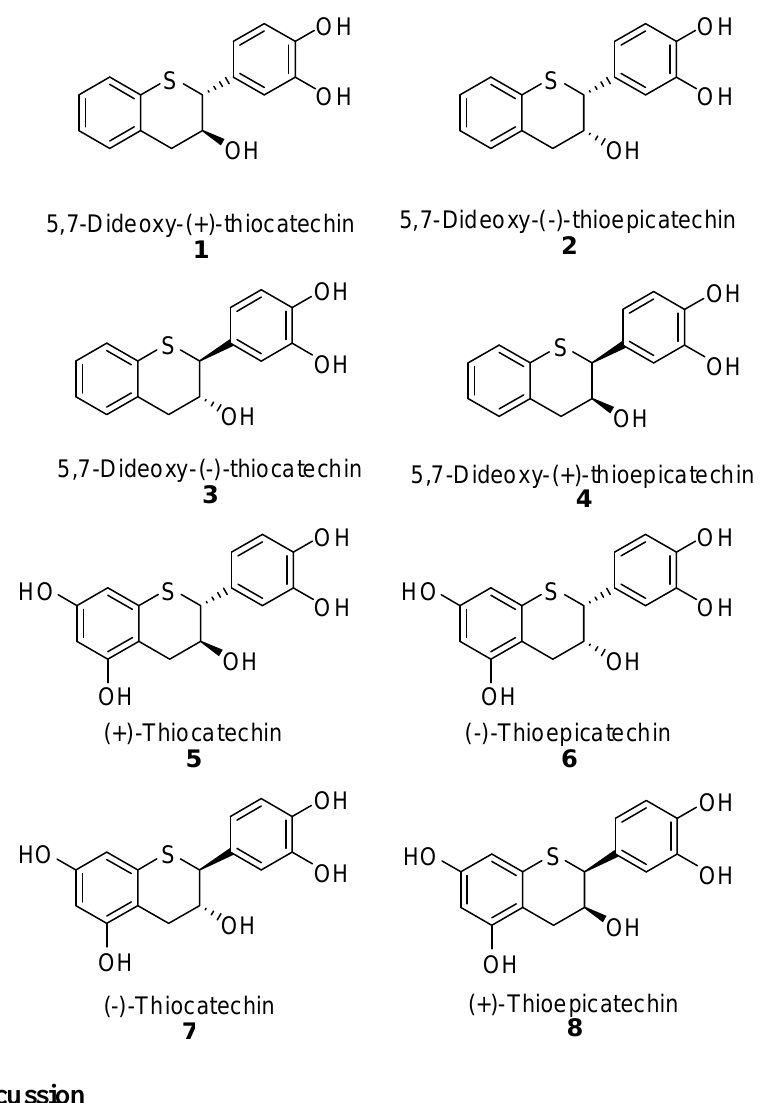
Figure 2. Structures of analogues of catechin and epicatechin